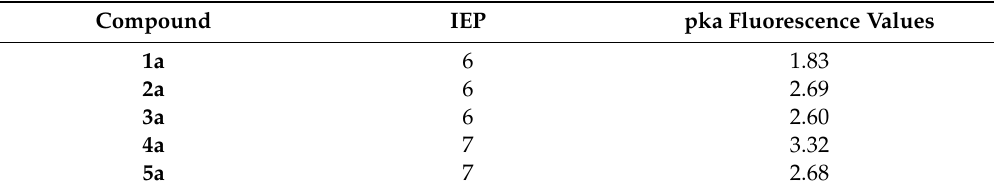
Figure 2. E ff ect of pH of N -alkyl-bis- o -aminobenzamide 1a – 5a at maximum emission [1 × 10 − 5 M]. Figure 2. Effect of pH of N -alkyl-bis- o- aminobenzamide 1a – 5a at maximum emission [1 × 10 − 5 M]. Table 1. Isoelectric point and pka’s of bis- o Table 1. Isoelectric point and pka’s of bis- o- aminobenzamides.